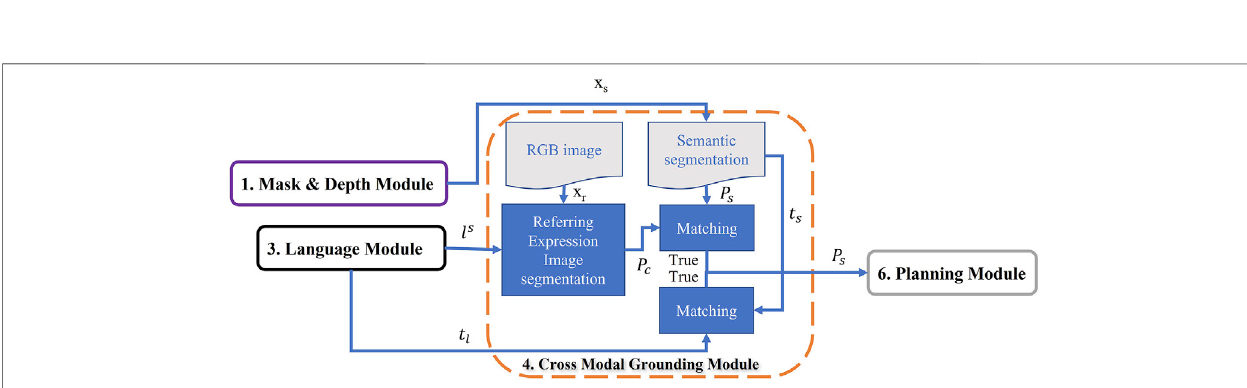
Frontiers in Robotics and AI |